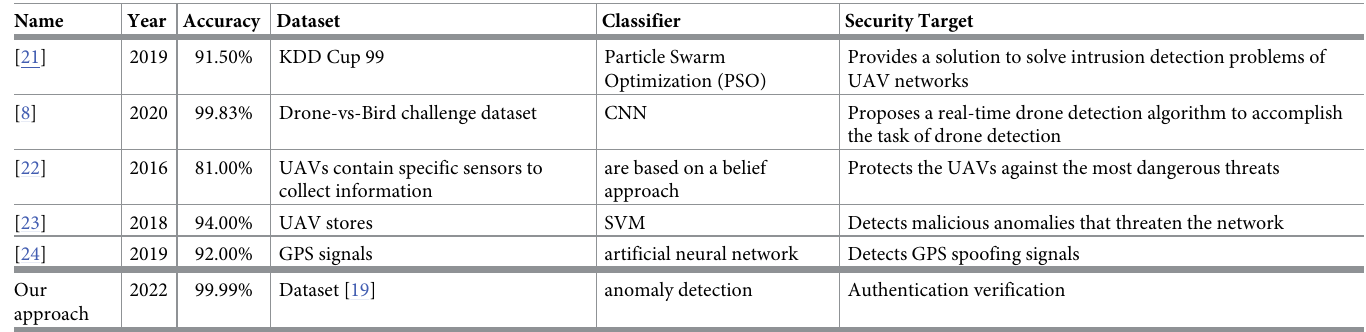
Table 7. Comparison with existing IDS